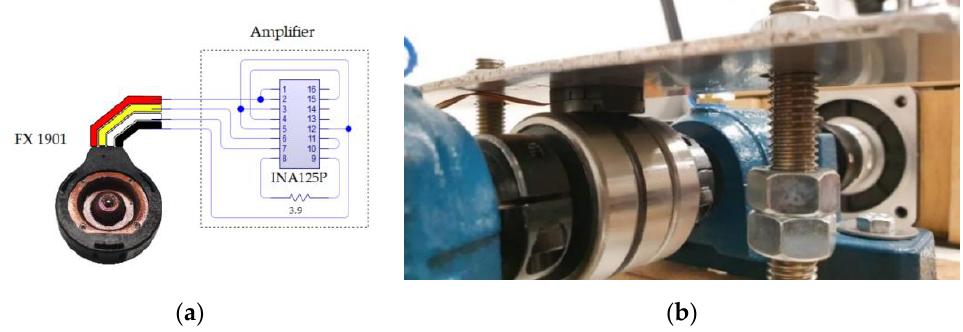
Table 2. Characteristic frequencies of the 6304-2R bearing at different regimes.